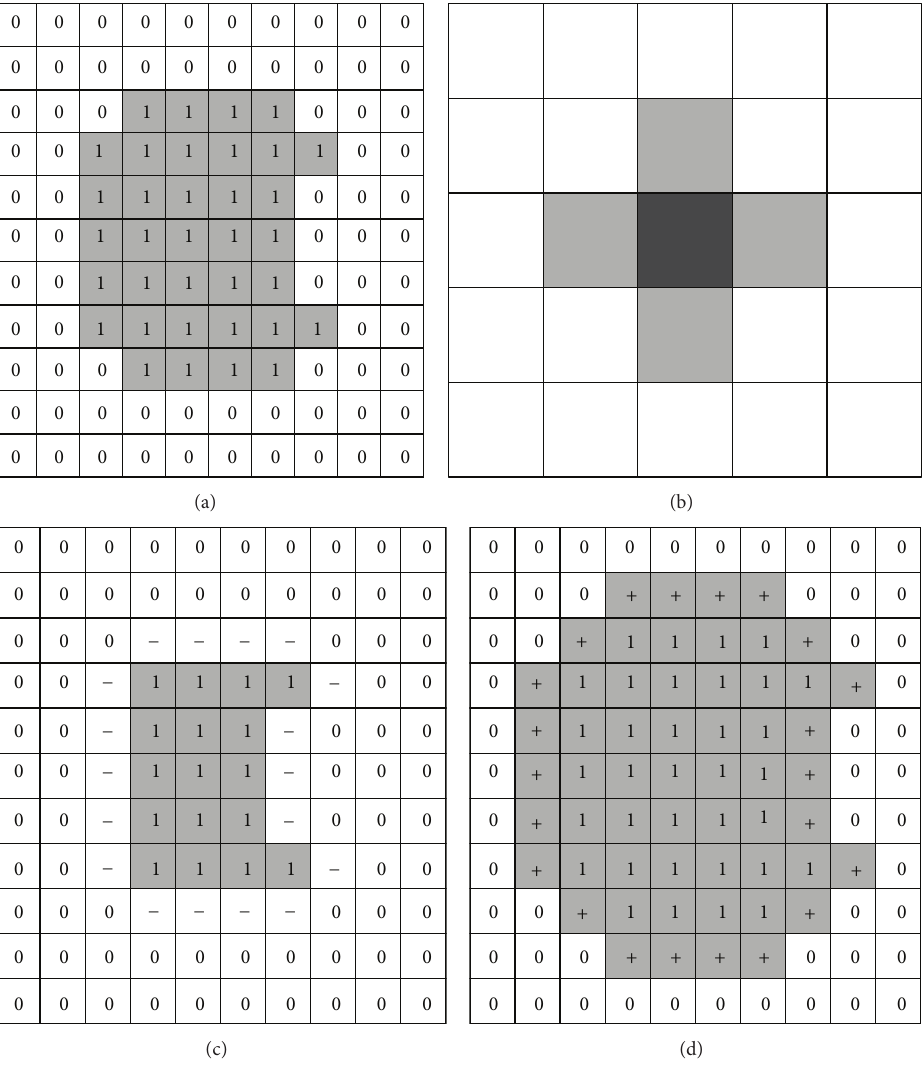
Figure 3: The operation of erosion and